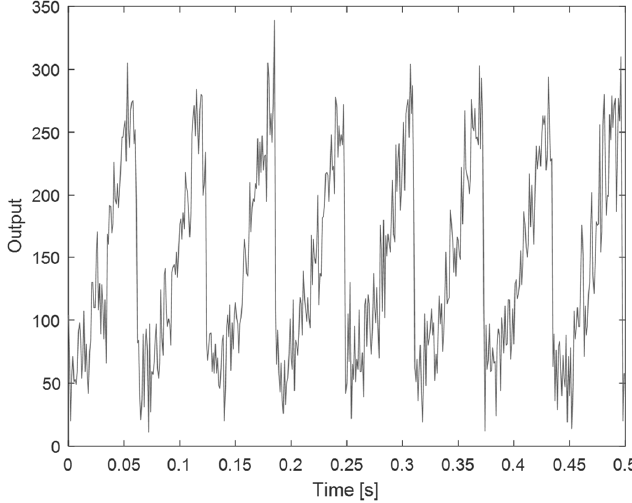
Figure 13. The output of the proposed sensor vs. time for the spinning gray gradient target placed 6.5 m from the sensor.